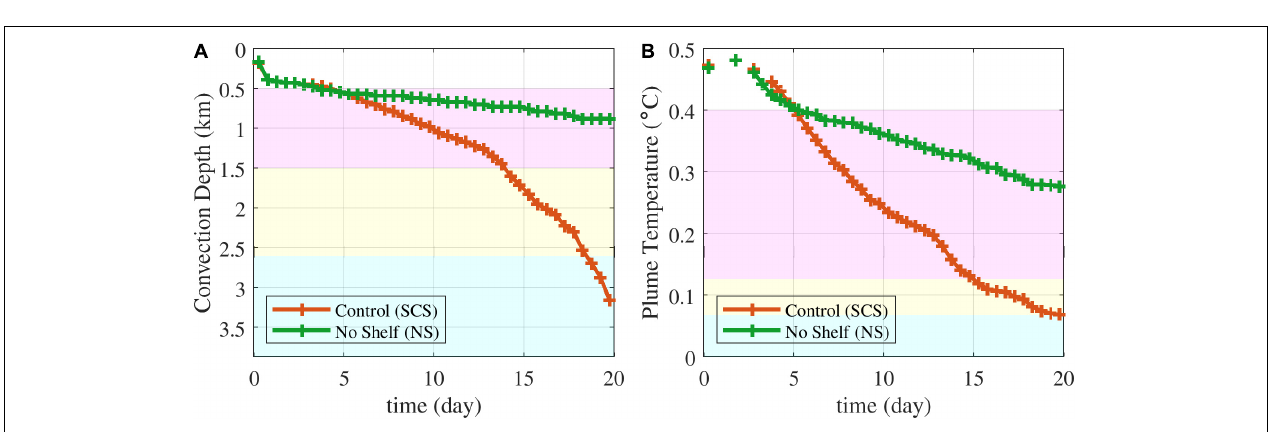
FIGURE 10 | Meridional sections of zonally averaged (A,B) potential temperature, (C,D) tracer concentration, and (E,F) velocity on day 20. Left panels (A,C,E) are results from the SCS experiment, reprinted for comparison with the right panels (B,D,F) , which are results from the NS experiment.